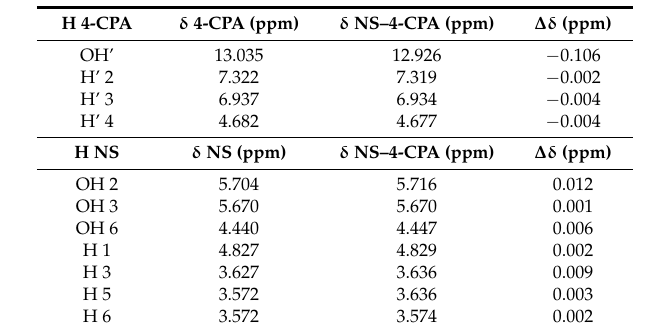
Table 1. 1 H-NMR assignments and chemical shifts for pesticides and the nanosponge (NS)— 4-chlorophenoxyacetic acid (4-CPA) complex.